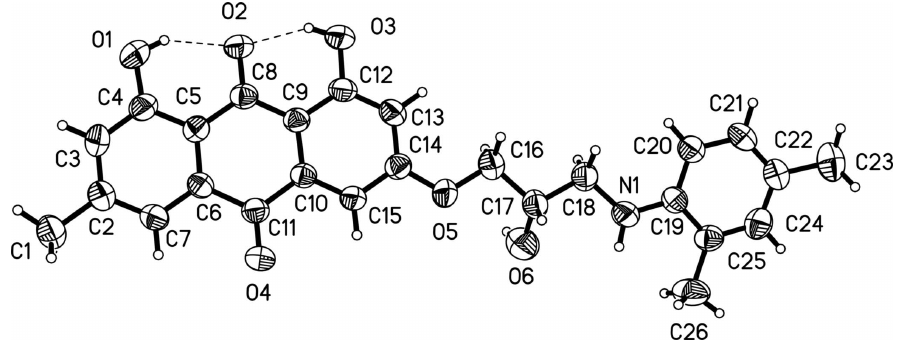
Figure 1 The molecular structure of the title compound, showing the atom-labelling scheme. Displacement ellipsoids are drawn at the 30% probability level. Dashed lines indicate hydrogen-bonding interactions.